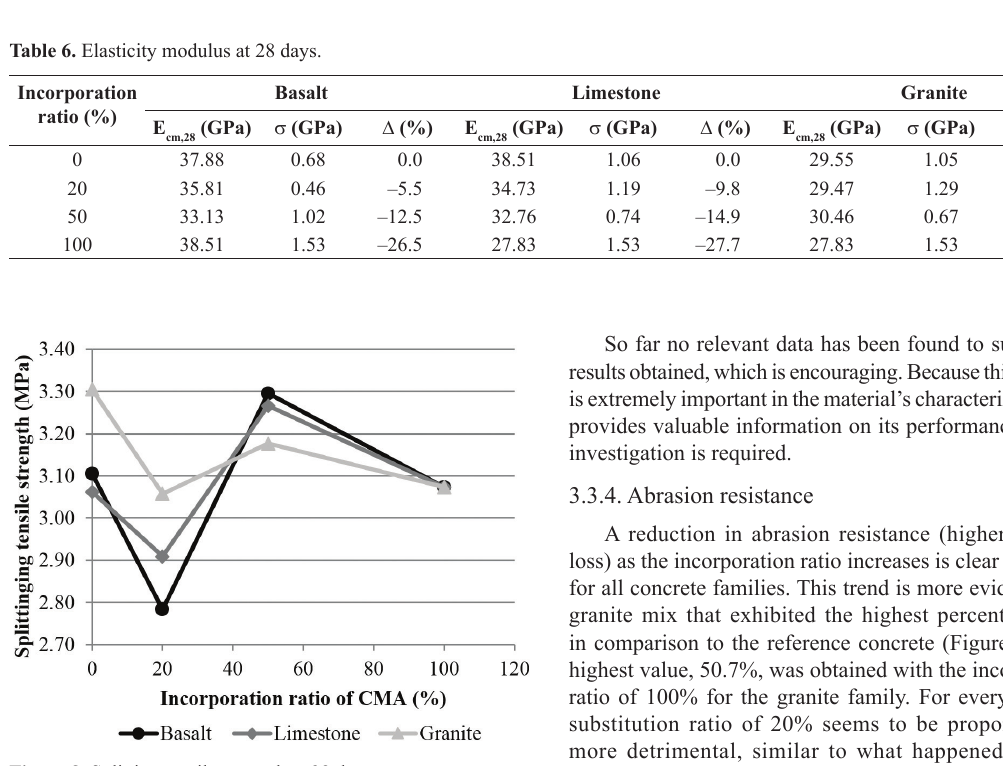
Figure 8. Splitting tensile strength at 28 days.